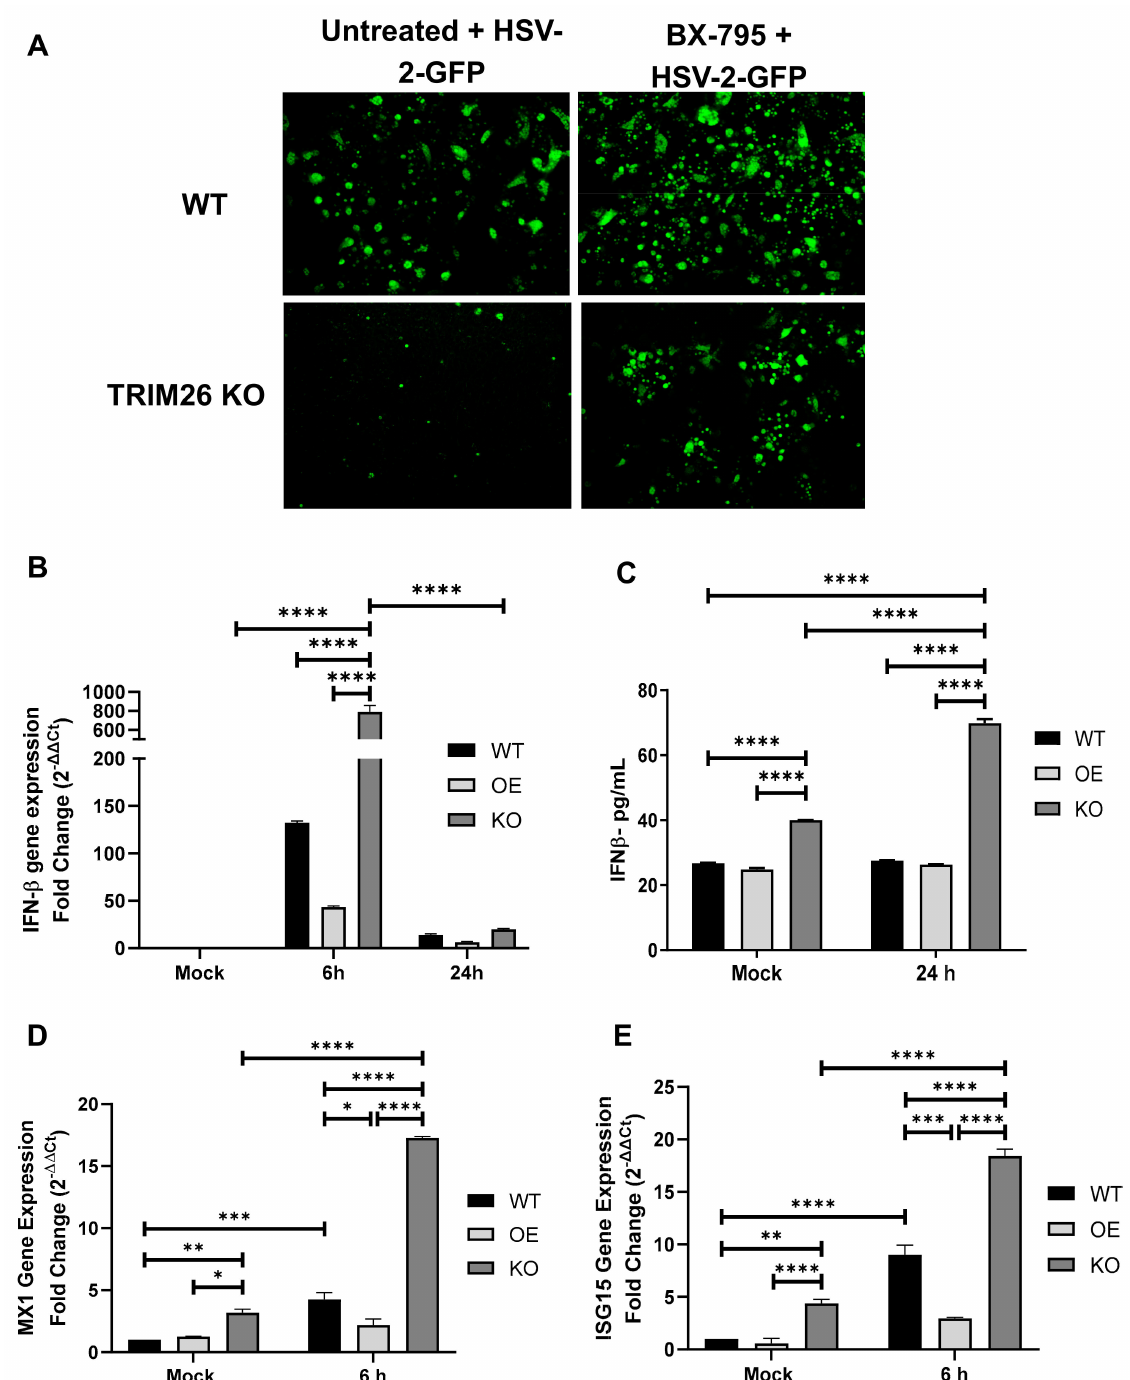
Figure 6. TRIM26 depletion significantly enhances IFN- β and interferon stimulated genes (ISGs) through IRF3 pathway during HSV-2 infection. ( A ) WT VK2 and TRIM26 KO cell lines were pretreated with BX795 (inhibitor of IRF3 signaling pathway) or left untreated for 1 h and then infected with HSV-2-GFP (MOI = 1). At 16 h post HSV-2 infection, cells were visualized by fluorescence microscopy, and images captured using an inverted immunofluorescent microscope (EVOS). Magnification x20. Representative images are shown from n = 4 experiments. ( B ) RNA was extracted from WT VK2 (WT), TRIM26 OE (OE) and TRIM26 KO (KO) cell lines after 6 h and 24 h post HSV-2 infection and subjected to qPCR to detect INF– β RNA ( n = 3), with statistical significance **** p < 0.0001. ( C ) WT, OE and KO cell lines were either uninfected (mock) or infected with HSV-2 (MOI = 1) for 24 h, supernatants collected for ELISA measurement of secreted IFN- β . Data shown are mean ± SEM ( n = 3) with statistical significance **** p < 0.0001. ( D and E ) RNA was extracted from WT, OE and KO cell lines after 6 h of infection or from mock infection controls and subjected to RT qPCR using specific primers for two